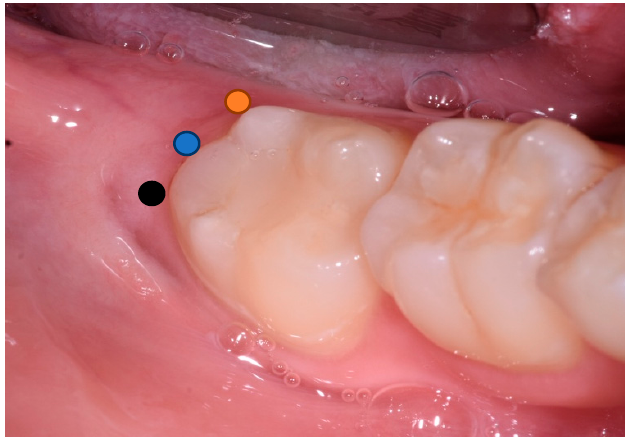
Figure 4. Pre-operative photograph showing disto-vestibular (DV) (black); disto-medial (DM) (blue); and disto-lingual (DL) (orange) points where probing depth (PD) was evaluated. Radiographic exploration was performed with a panoramic radiograph, and just in cases showing a close relation between an LTM and the inferior alveolar nerve, a pre-operative CBCT was taken.